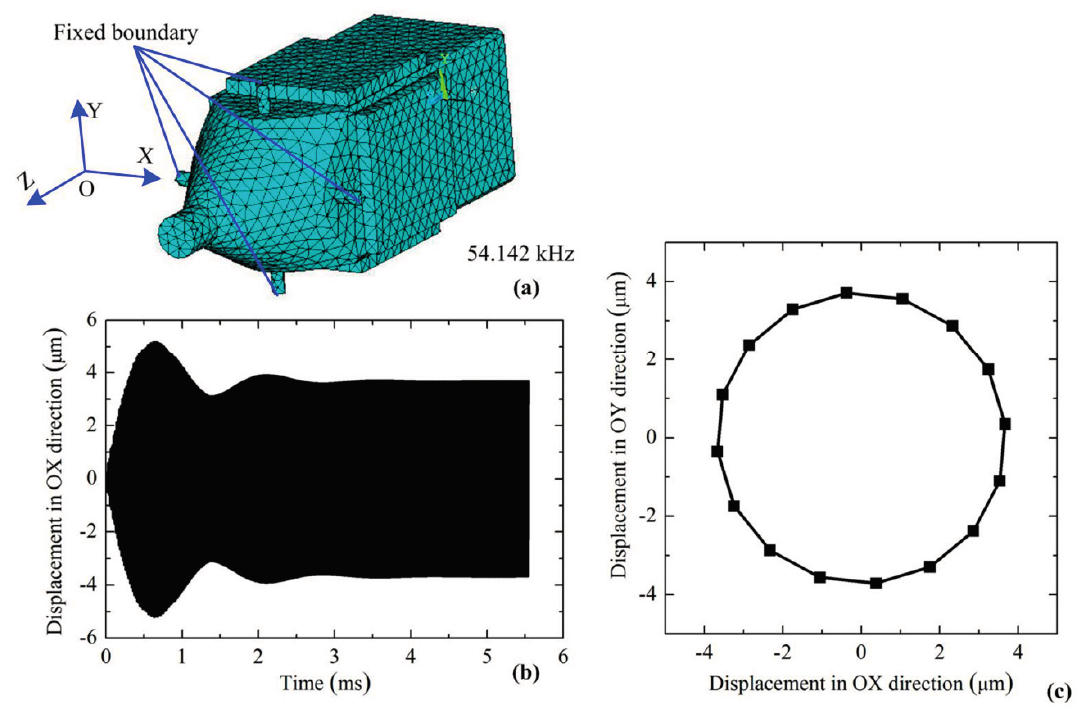
Figure 6. Movement of the end tip under fixed boundary condition: ( a ) FEM model; ( b ) the displacement response along OX direction; ( c ) the steady motion in XOY